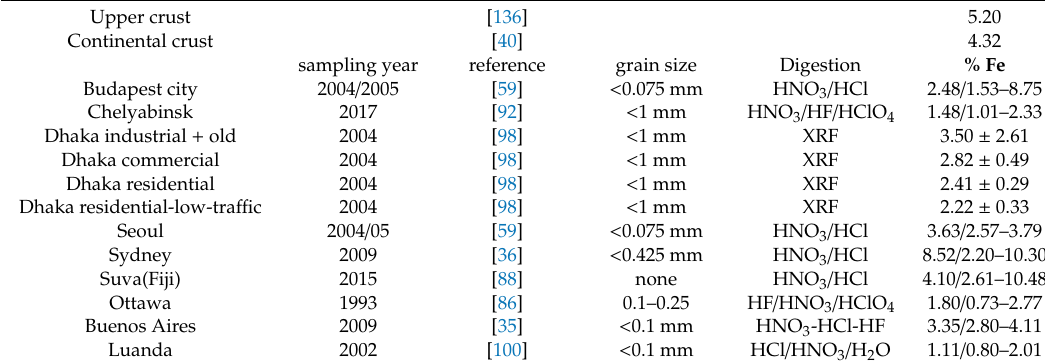
Table A22. Iron in road dust.